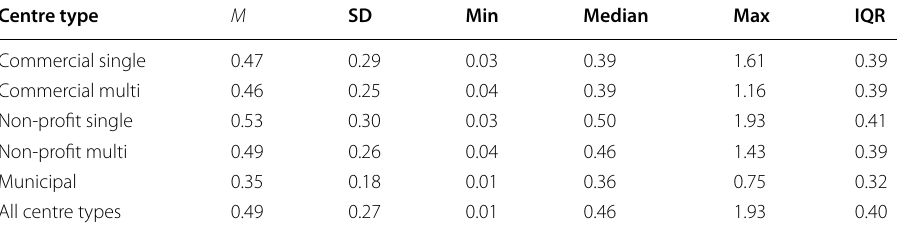
Table 6 Average differences between lowest and highest AQI scores of individual classrooms by centre